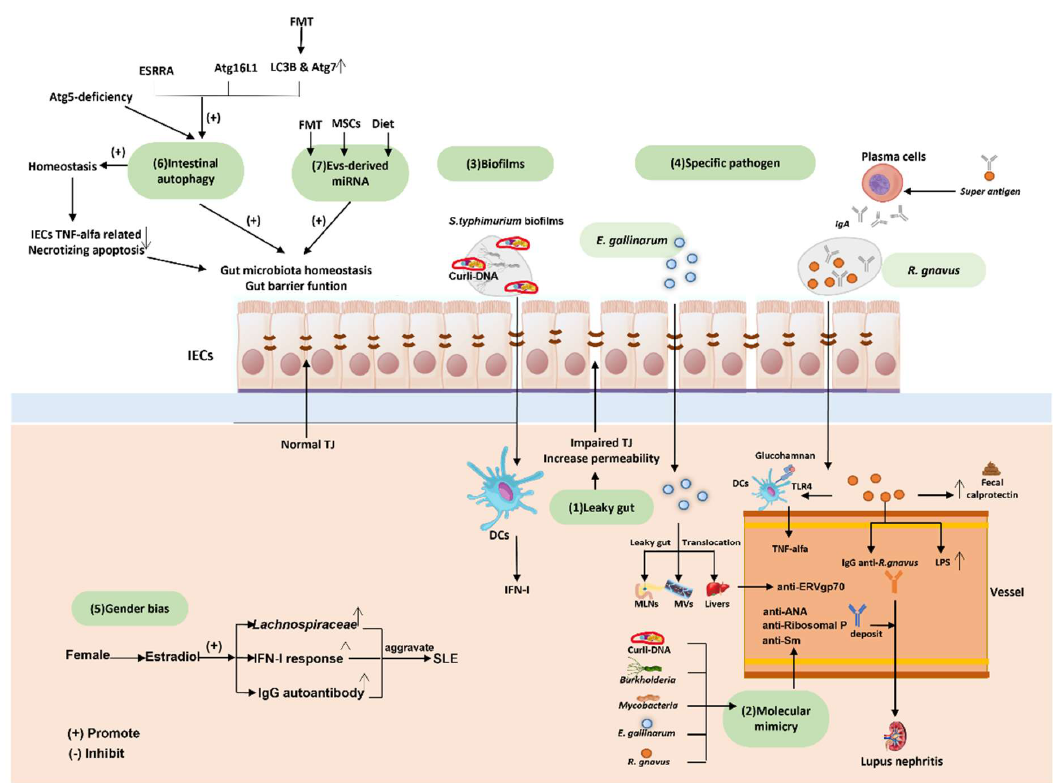
Figure 6. Mechanisms of enteric dysbiosis in SLE. A leaky gut can facilitate the entrance of microor- ganisms, by either the blood stream or the lymphatic system, and affect distal organs; one such example is the deposition of biofilms on the kidneys. Some bacteria ( Enterococcus gallinarum ) disrupt the intestinal epithelium and translocate to distal organs, such as the liver, which, upon induction of ERV gp70 liver overexpression, can lead to autoimmune syndromes. Ruminococcus gnavus displays harmful responses, as it expresses a B-cell superantigen that results in the overproduction of IgA, as well as possessing a capsule that facilitates intestinal colonization. In addition, this bacterium secretes the inflammatory factor TNF- α and produces an antigen that causes the generation of anti-dsDNA antibodies and aggravates lupus nephritis. ATG, autophagy-related protein; DCs, dendritic cells; E. gallinarum , Enterococcus gallinarum ; ESRRA, estrogen-related receptor alpha; FMT, fecal microbiota transplantation; IECs, intestinal epithelial cells; IFN-I, type I interferon; LC3B, microtubule-associated protein 1 light chain 3B; LPSs, lipopolysaccharides; MLNs, mesenteric